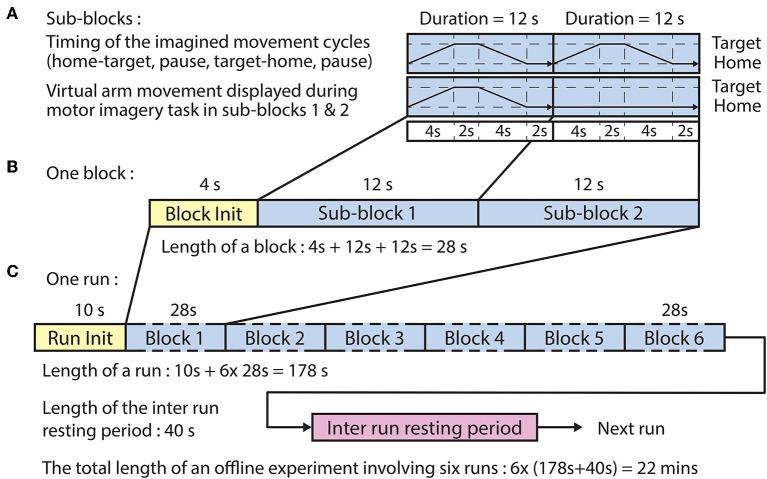
Timing of the offline paradigm. (A) Timing of the imagined movement cycles in sub-blocks 1 and 2 between a home position and one of the three corresponding target positions. In both sub-blocks, the subject performed the same motor imagery movement cycle that comprised home-to-target (4 s), pause at target (2 s), target-to-home (4 s), and pause at home (2 s) intervals. However, visual representation of the required movement was only displayed in sub-block 1. (B) A block comprised a block initialization period and two sub-blocks. (C) A run comprised a run initialization period and six blocks corresponding to the six targets in a randomized order (the six targets comprised three targets per arm).